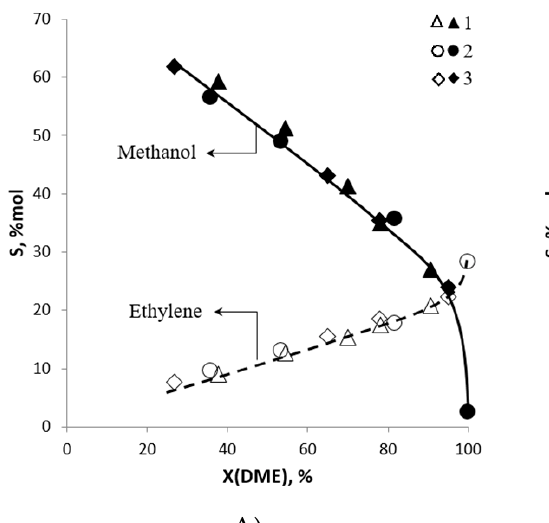
А ) В ) Figure 6. Product selectivity (S, mol %) as a function of DME conversion (X (DME), %). 1—HZSM- 5/Al 2 O 3 , 2—Zr- HZSM-5/Al 2 O 3 , 3—Mg- HZSM-5/Al 2 O 3 . А ) methanol (solid line) and ethylene (dashed line); В ) propylene (solid line) and butenes (dashed line).